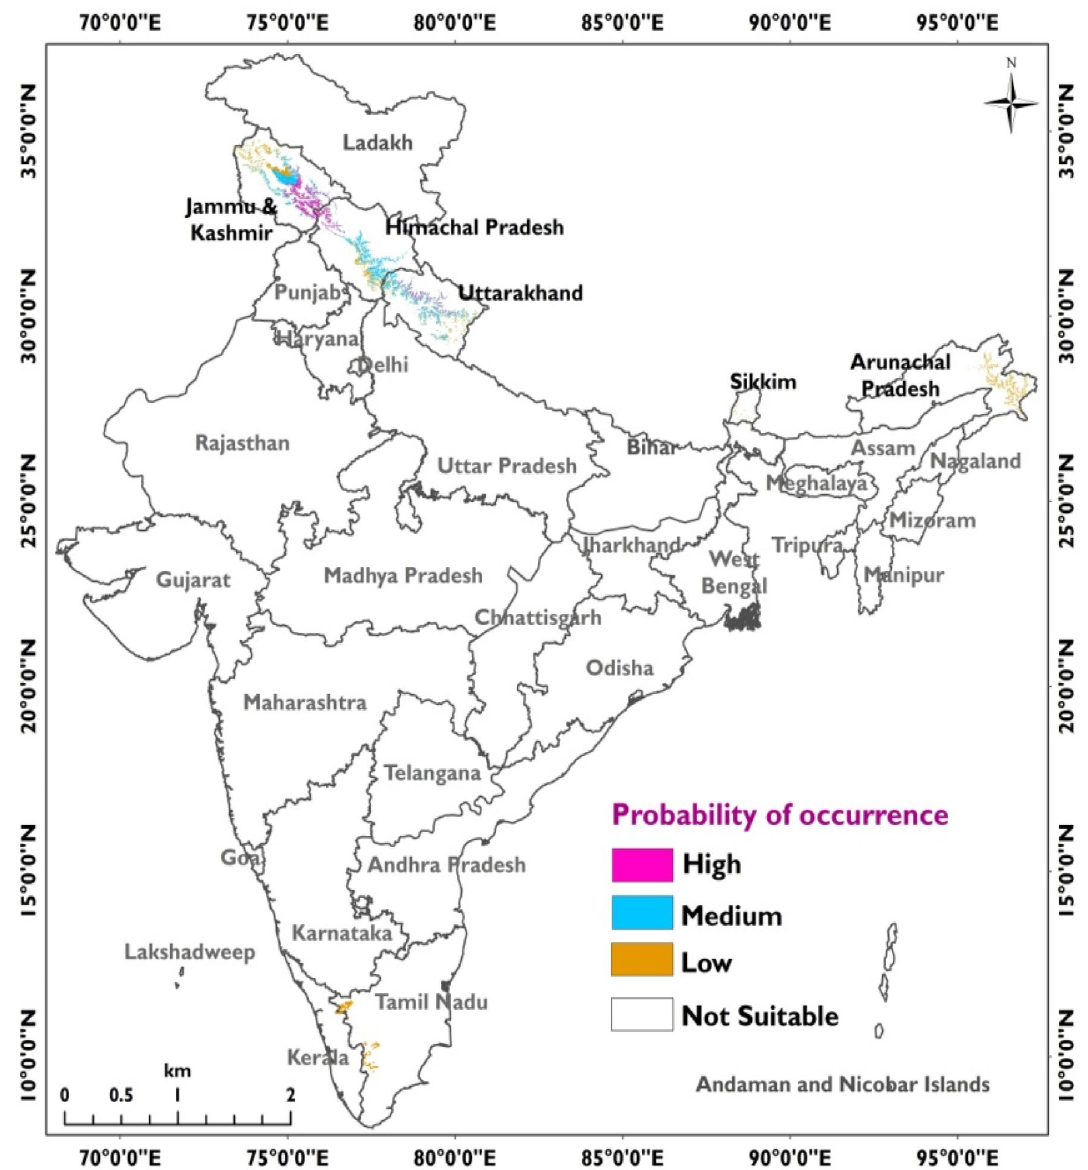
Figure 5. Modelled probable niche areas of Crocus sativus (Saffron) in India (prepared using ArcGIS 10.4.1; https:// www. esri.